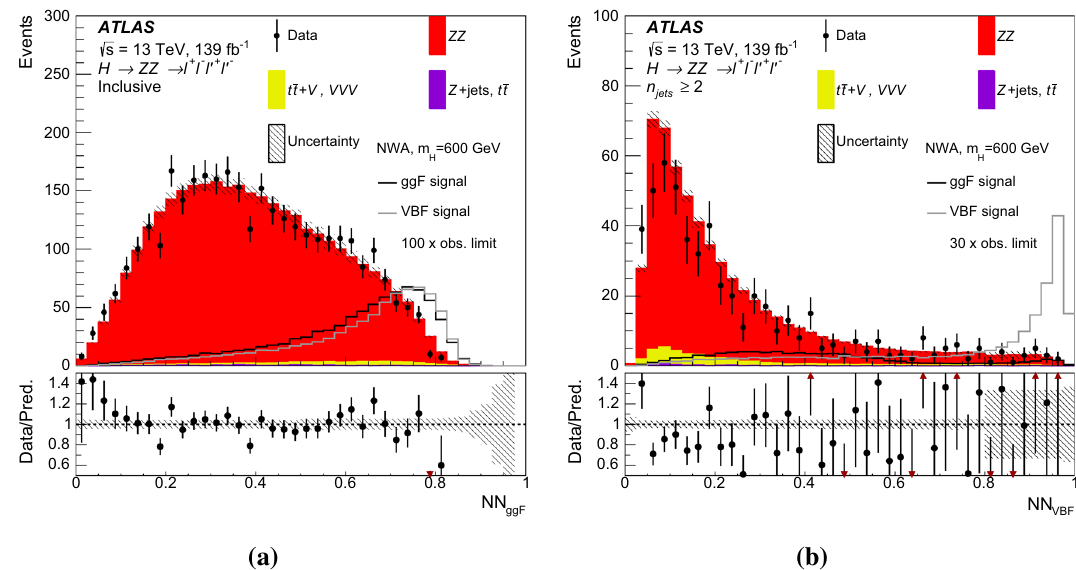
Fig. 1 The output of a the ‘ggF classifier’ (NN ggF ) and b the ‘VBF classifier’ (NN VBF ) for the events passing the common event selections for the data, the SM background and NWA signal events with a mass of 600 GeV. For b the ‘VBF classifier’ output, an additional requirement of at least two jets in the event, is applied. The signal cross section is set